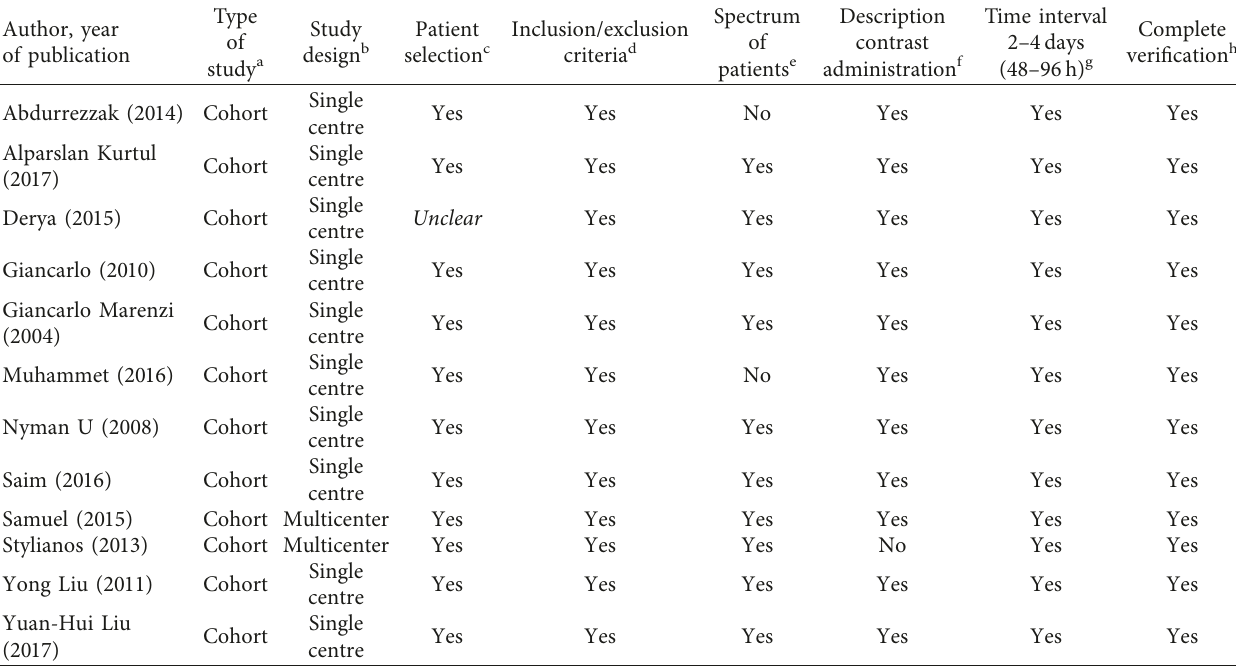
Table 1: Methodological and design criteria of all 12 included articles